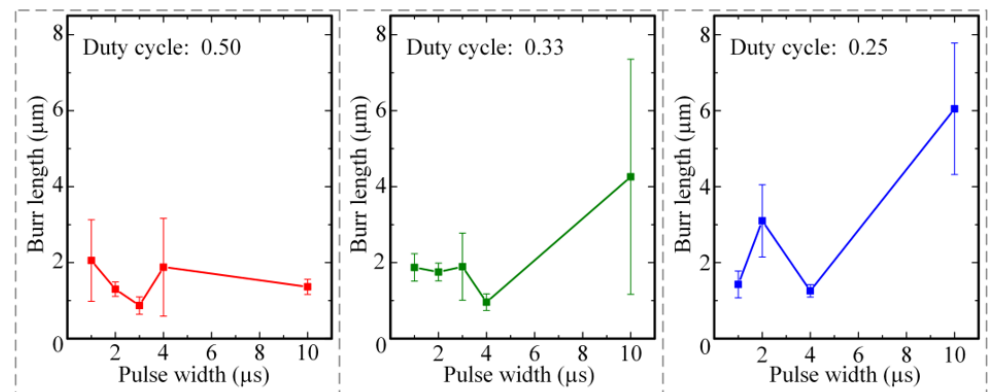
Figure 9. Influence of pulse width and pulse duty cycle on the average length of the hole mouth burrs.